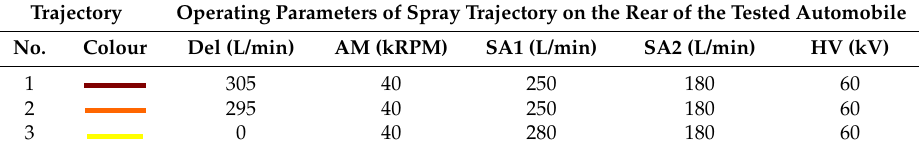
Table 3. Operating parameters of spray trajectory on the rear.